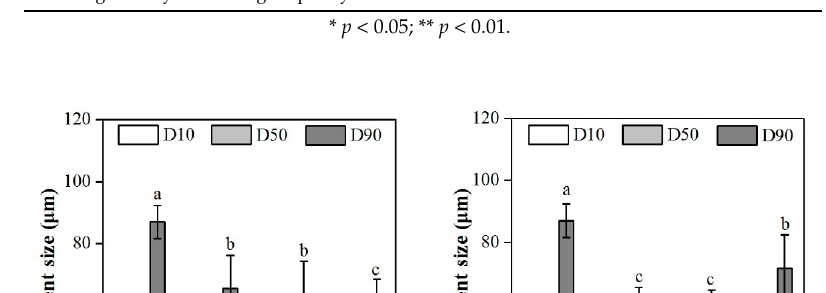
Table 5. Variance analysis of the effects of flushing velocity and frequency on the particle size of residual sediments in emitters.